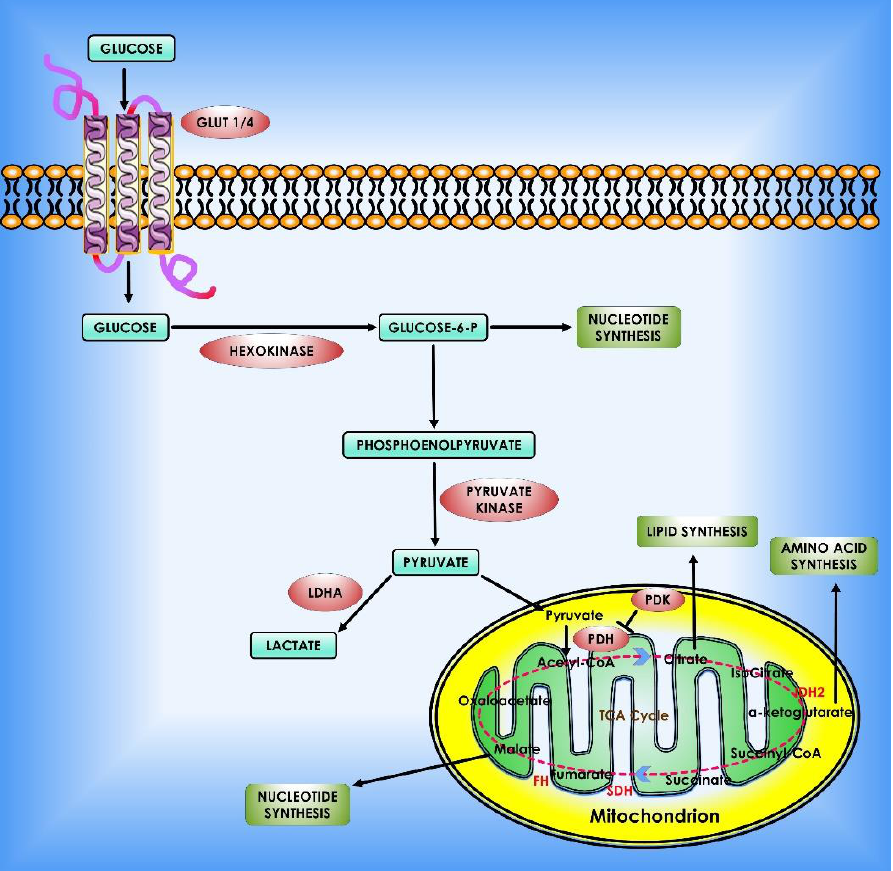
Figure 2. Glucose metabolism in cancer cells. When glucose enters the cell via glycolysis, it is phosphorylated by HK to glucose-6 phosphate, which is then converted by glycolysis to pyruvate in the cytosol. Under an aerobic environment, normal cells employ pyruvate dehydrogenase (PDH) to convert the majority of pyruvate to acetyl-CoA. The acetyl-CoA is subsequently oxidized via the TCA cycle, providing sources of ATP production. On the contrary, the molecular mechanisms of glucose consumption in cancer are switched from oxidative phosphorylation to glycolysis. Furthermore, cancer cells require the creation of new macromolecules to proliferate (for example, nucleic acids, lipids, and proteins). Critical enzymes which might be viable targets for cancer treatment are indicated in orange. TCA enzymes iso-citrate dehydrogenase 2 (IDH2), succinate dehydrogenase (SDH), and fumarate hydratase (FH) which are known to be mutated in cancer are depicted in red within the